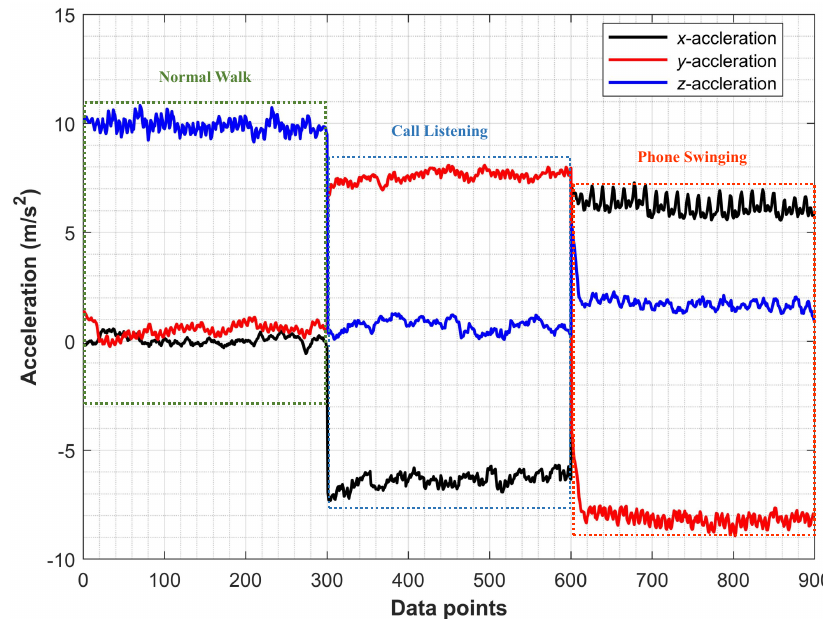
Figure 8. x , y , and z accelerations for user activities.